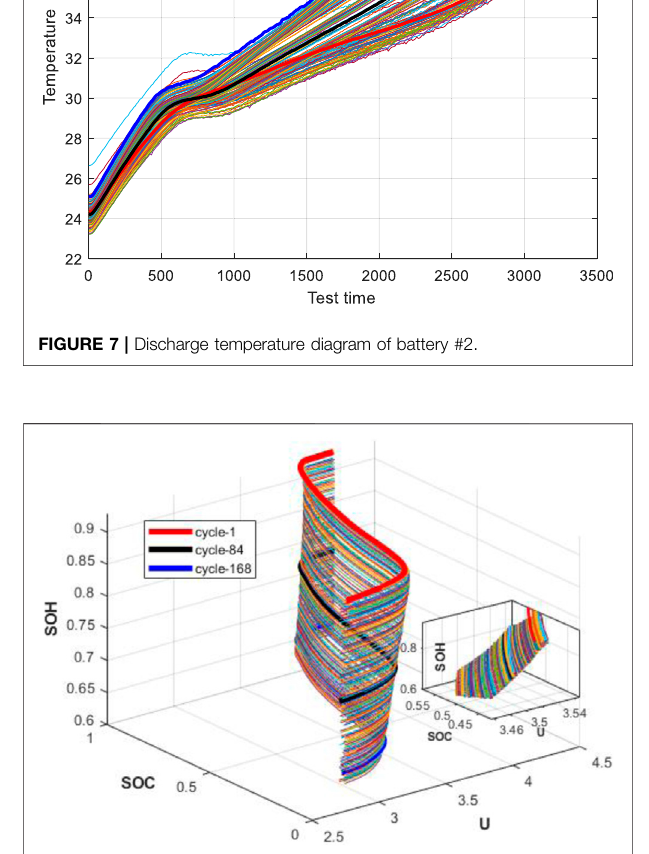
FIGURE 10 | SOC-U-Time relationship diagram of battery